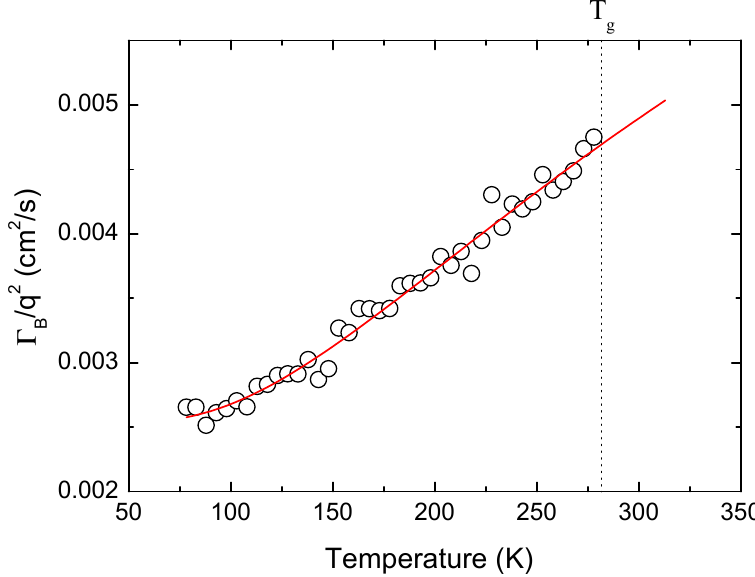
Figure 7. Temperature dependence of the longitudinal kinematic viscosity (open circles) along with the best-fitting result (red solid line) based on Equation (6). The vertical dotted line denotes the glass transition temperature.